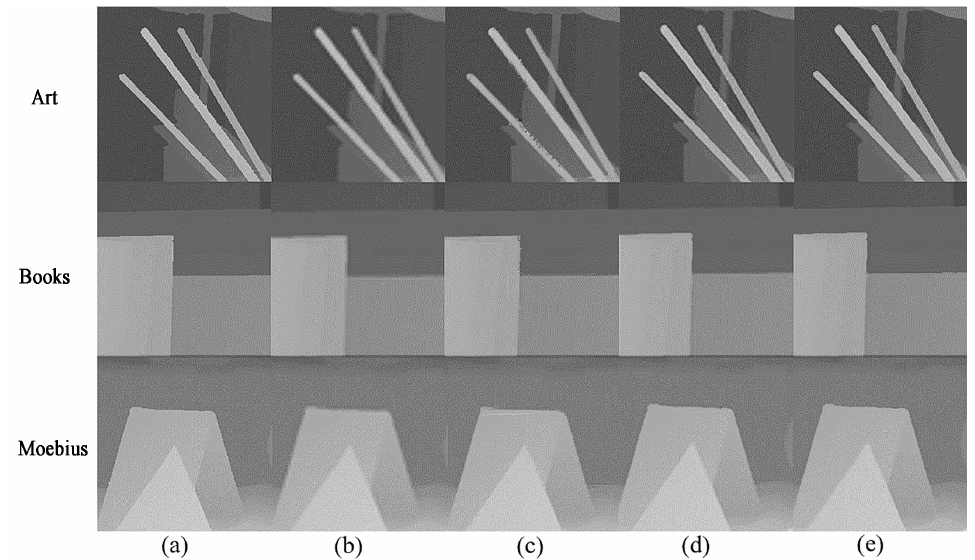
Figure 6. Comparison of the results of up-sampling depth maps with several methods: ( a ) Ground Truth; ( b ) Bicubic; ( c ) TVG; ( d ) SRCNN; ( e ) Method proposed in this